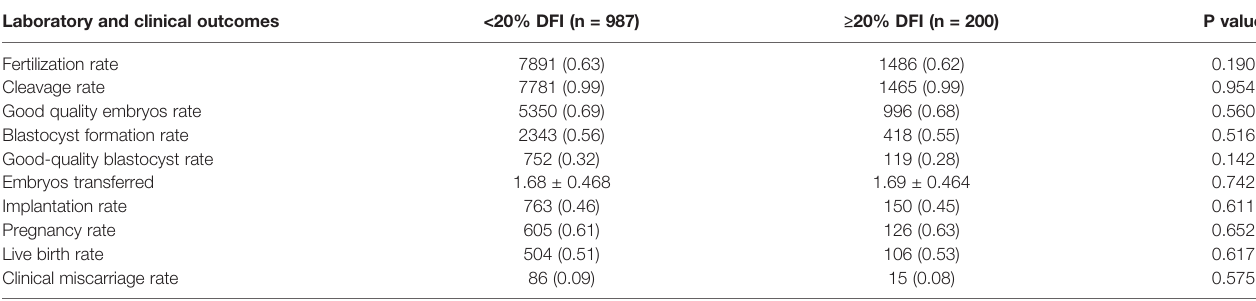
TABLE 3 | Laboratory and clinical outcomes in group 1 with high and low DFI.